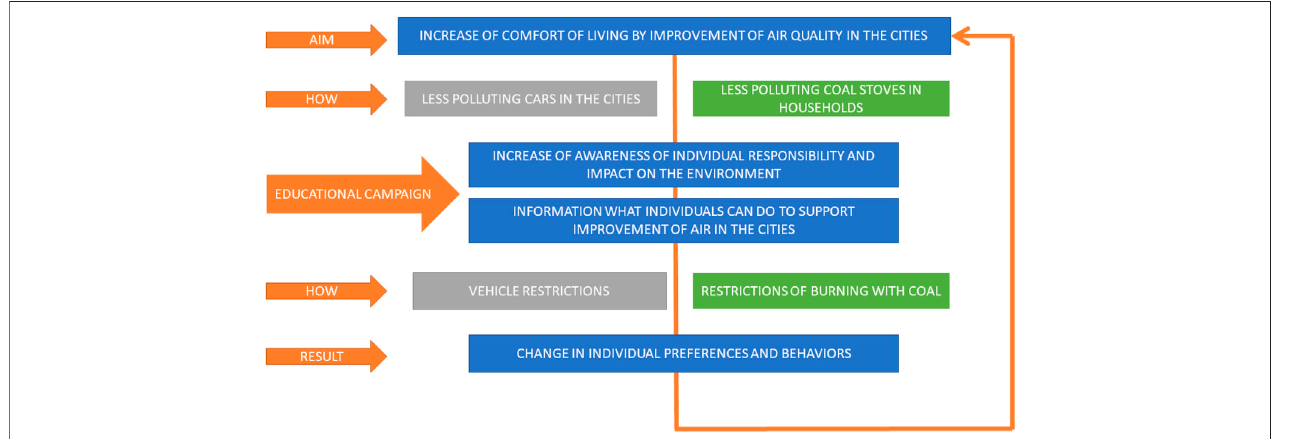
FIGURE 2 | Framework of actions needed to fi ght with urban air